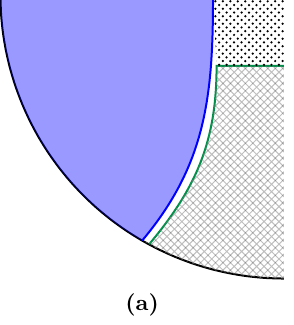
Figure 12. (a) The first portion of the dividing curve α j starts at the right endpoint of V j , and follows the HRRT surface γ until it crosses into I − ( E ) . At this point, the dividing curve starts V W j to follow P F . Points with dot-like shading are in I − ( E ) , and points with cross-like shading j ∩ W j are in J − ( E ) c . (b) If the dividing curve terminated anywhere in the interior of F , then we W j